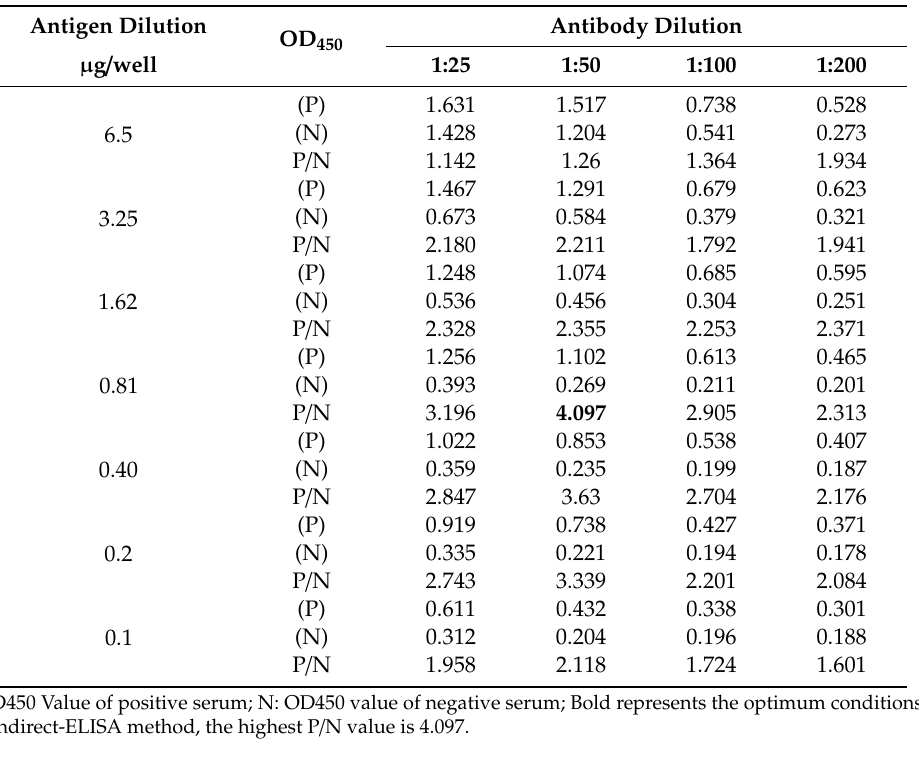
Table 1. Determination of the optimal rHc-HCA59 coating concentration and serum dilution for indirect-ELISA.